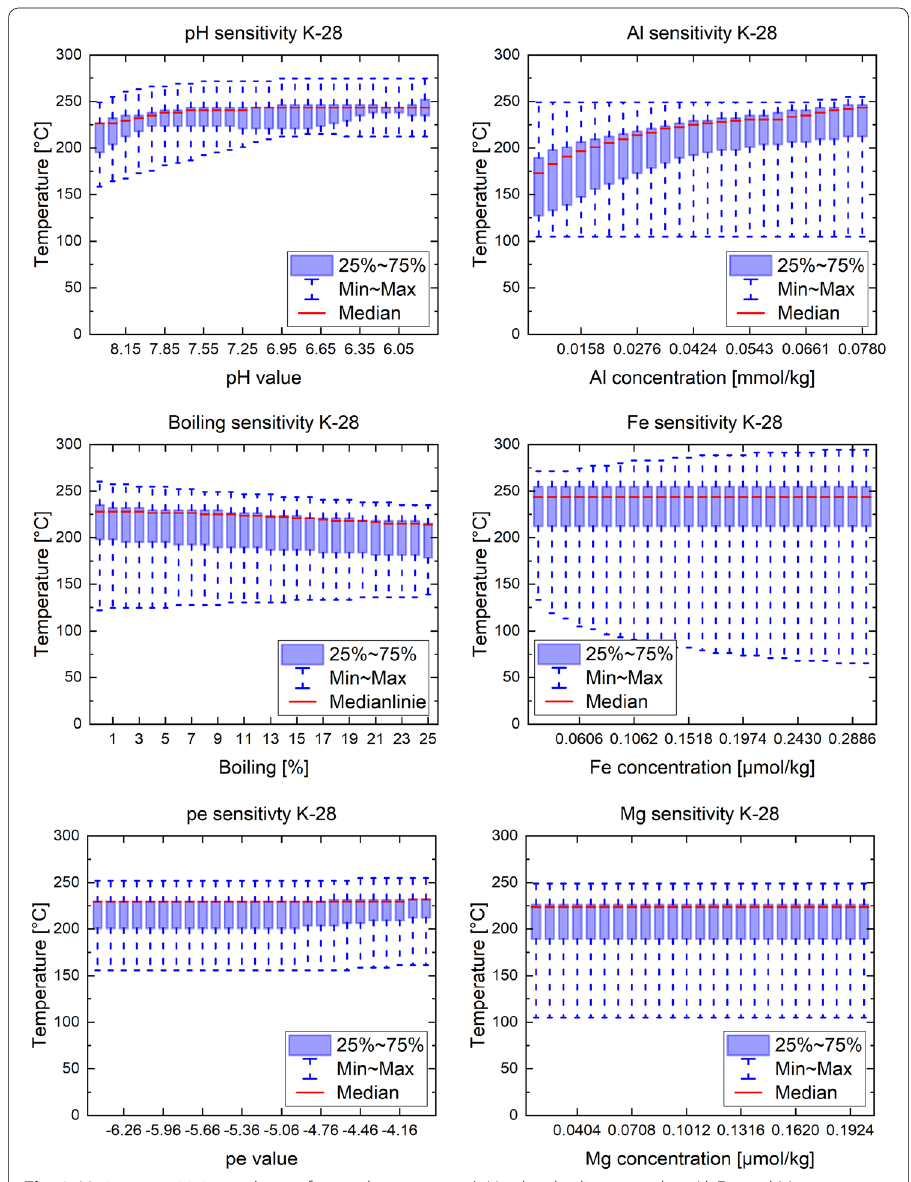
Fig. 2 Various sensitivity analyses of several parameters (pH value, boiling, pe value, Al, Fe, and Mg parameters around the initial measured value such that a minimal temperature spread is found. In an ideal case, the equilibrium temperatures of each mineral phase of the reservoir assemblage converge to one discrete reservoir temperature. Also unknown parameters can be estimated in this manner. Thus, a geochemical foreknowledge of the geothermal system is needed to make an educated guess for the unknown parameter, which then can be estimated towards best-fit conditions. To statistically evaluate the resulting box plots, the mineral set has to remain unchanged throughout all variations. Minerals that do not equilibrate due to over- or undersaturation or have multiple inter- sections with the equilibrium line in any step of the sensitive analyses were discarded